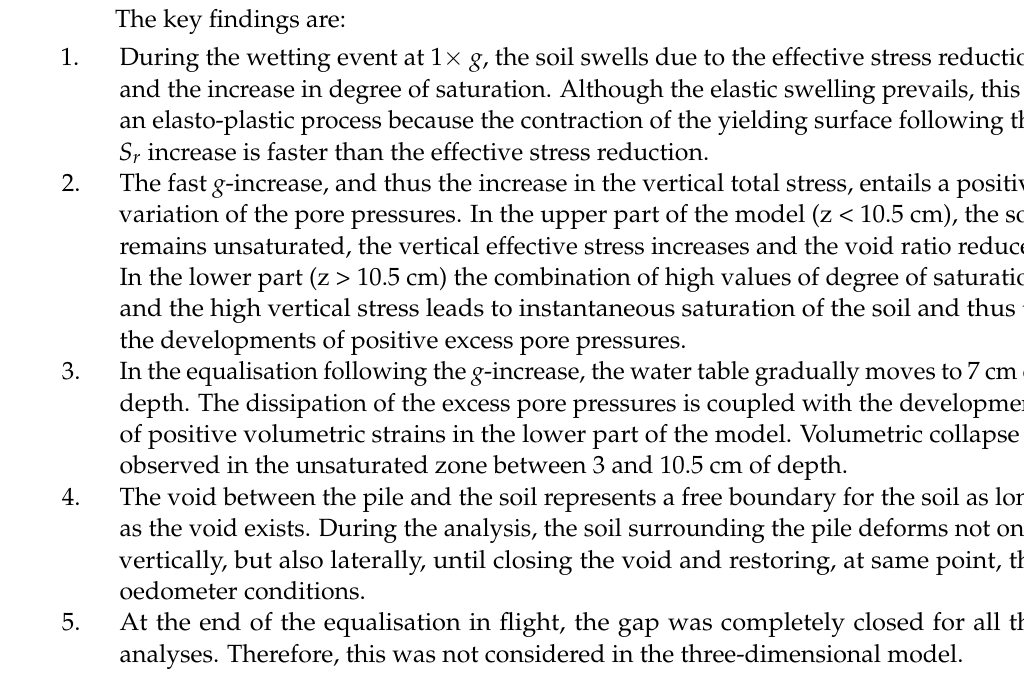
Figure 4. Stress history of the model. Profiles obtained by FEM analyses (test